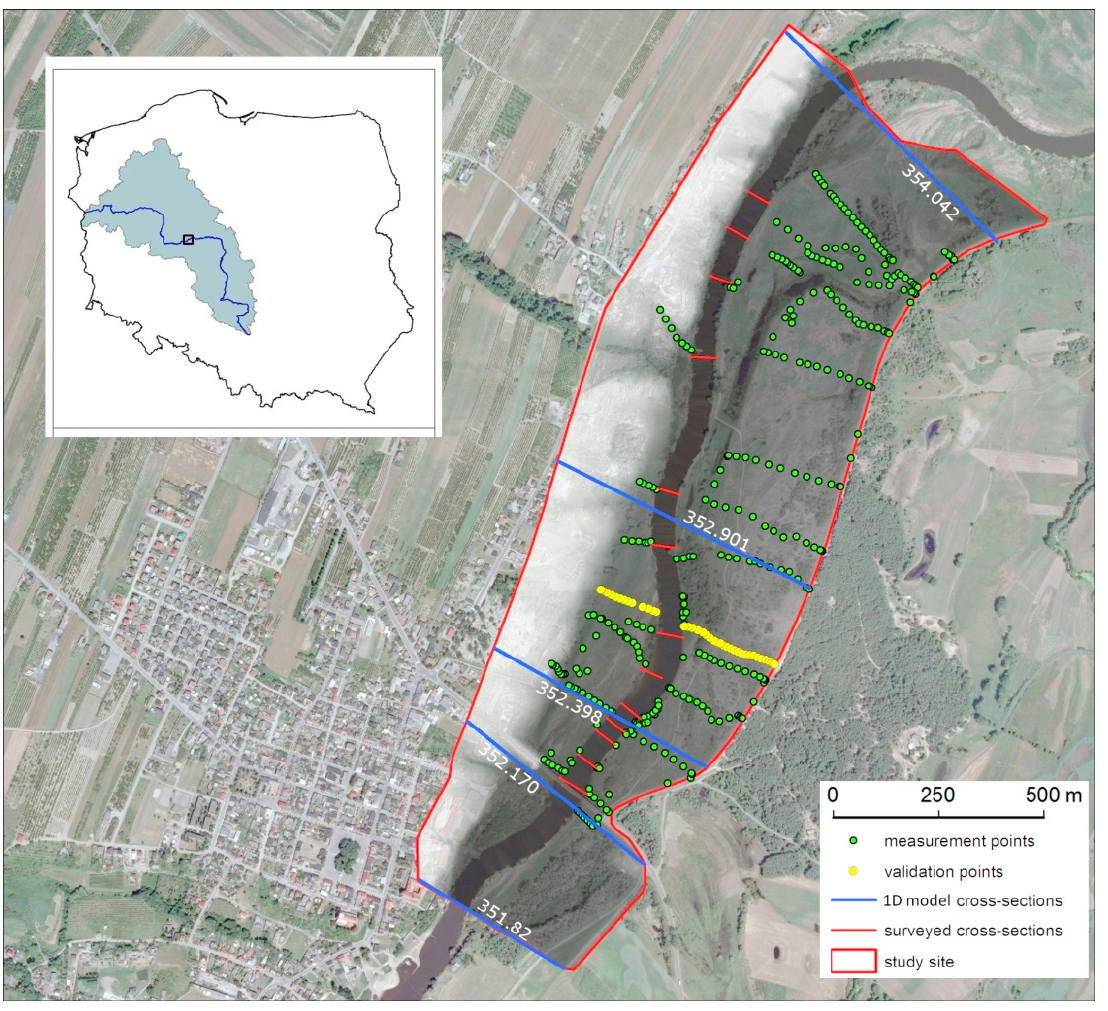
Figure 2. Study site location.